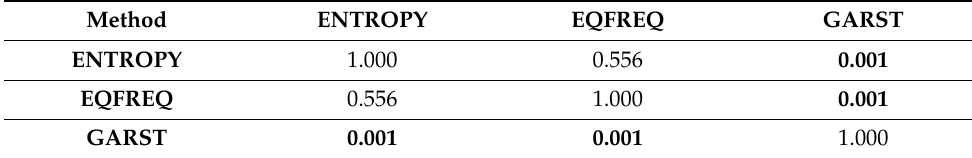
Table 6. The results of post hoc